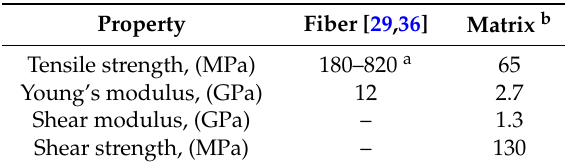
Table 5. Mechanical properties of fiber and